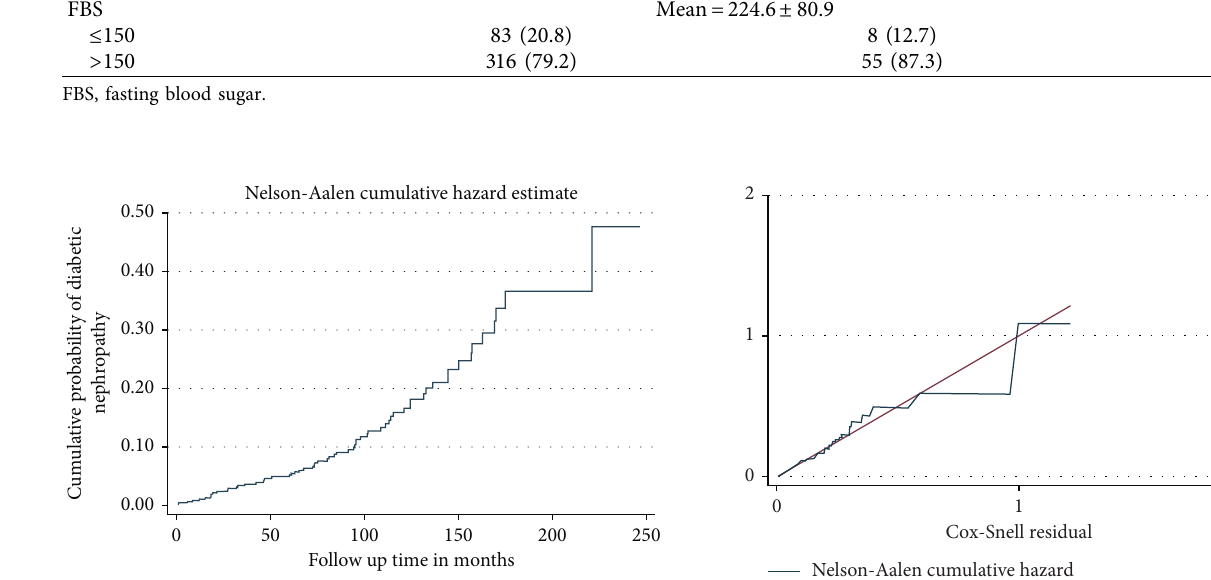
Figure 1: The Nelson–Aalen estimated cumulative curve showing cumulative probability of diabetic nephropathy among type 2 DM patients in University of Gondar Comprehensive Specialized